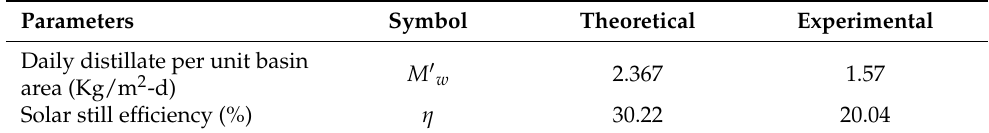
Table 7. Theoretical and experimental rates and efficiencies of distilled water production in the solar still. Parameters Symbol Theoretical Experimental Daily distillate per unit basin M (cid:48) w 2.367 1.57 area (Kg/m 2 -d) Solar still efficiency (%) η 30.22